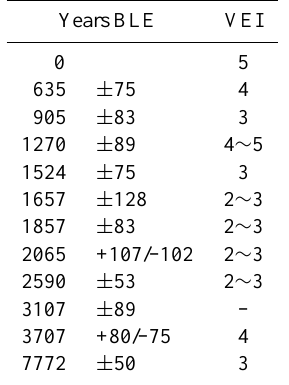
Table 1. Volcanic Explosivity Indexes and ages of known erup- tions with magnitude VEI ≥ 3 of El Chich´on volcano from different sources (Duffield et al., 1984; Tilling et al., 1984; Esp´ındola et al., 2000; Mac´ıas et al., 1993, 2003, 2007, 2008). The dates are aver- ages of the reported radiometric age in years before the last (1982) eruption. The dash indicates an unknown VEI value. For the erup- tion of 1270years BLE we adopted a VEI 5 based on personal com- munications by J. L. Mac´ıas and J. M. Esp´ındola who are carrying out most of the field work on El Chich´on deposits, and consider that such eruption was at least as large as the 1982 one. For the erup- tions in the range 2 ∼ 3, we adopted the higher value on the premise that deposits of eruptions older than 1000years that remain recog- nizable in a tropical humid climate more probably correspond to the upper end of the